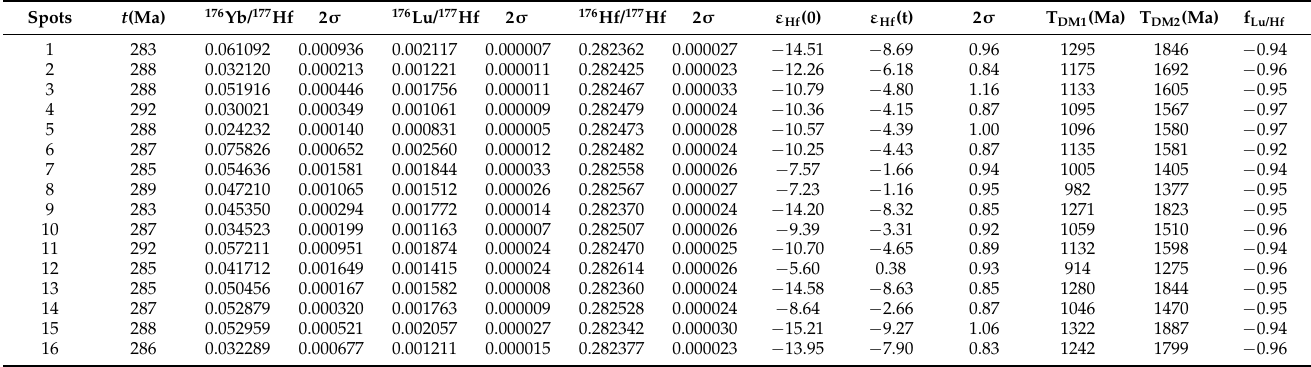
Table 3. Hf isotopic compositions for zircons of the Zhaojinggou monzogranite, Inner Mongolia.